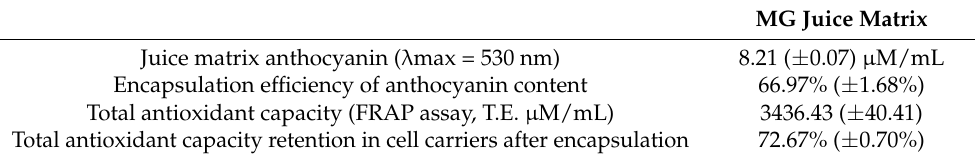
Table 1. Characterization of MG juice matrix and the encapsulation efficiency of the polyphenolics from the juice using L. casei cell carrier. For this characterization, the antioxidant activity of the juice before and after encapsulation was